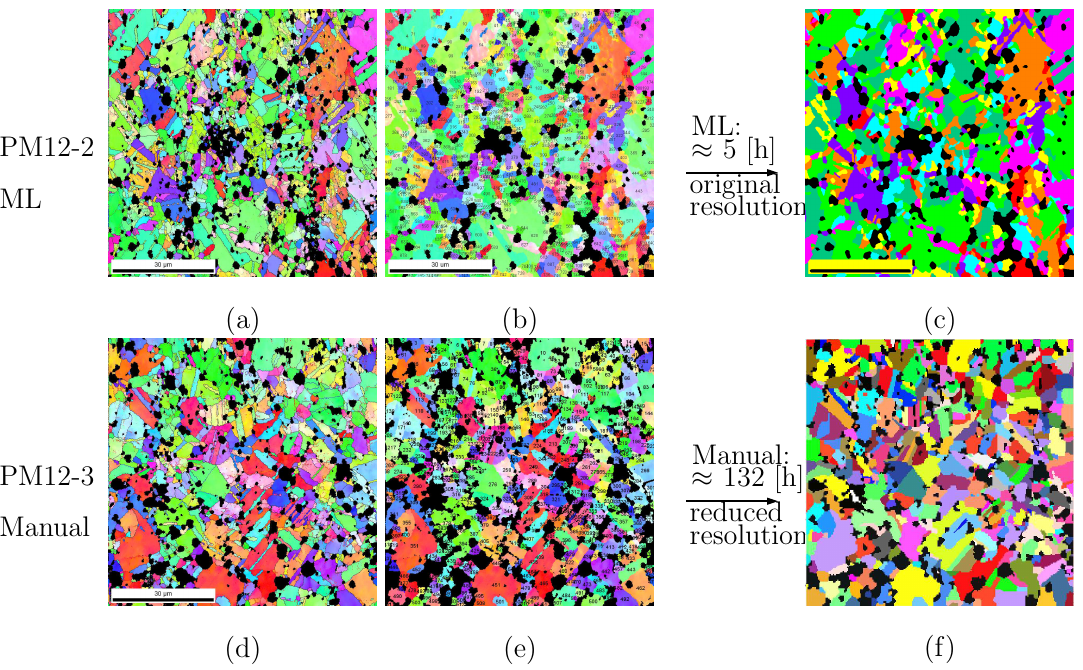
Figure 8. Comparison of image segmenations between autonomous algorithms and manual work for PM12-2 (upper row) and PM12-3 (lower row) Ag/SnO 2 composites, respectively: ( a , d ) original EBSD images; ( b , e ) numbered Ag grains from experiment; ( c , f ) segmented images with perfect pixel colors and ready for meshing.